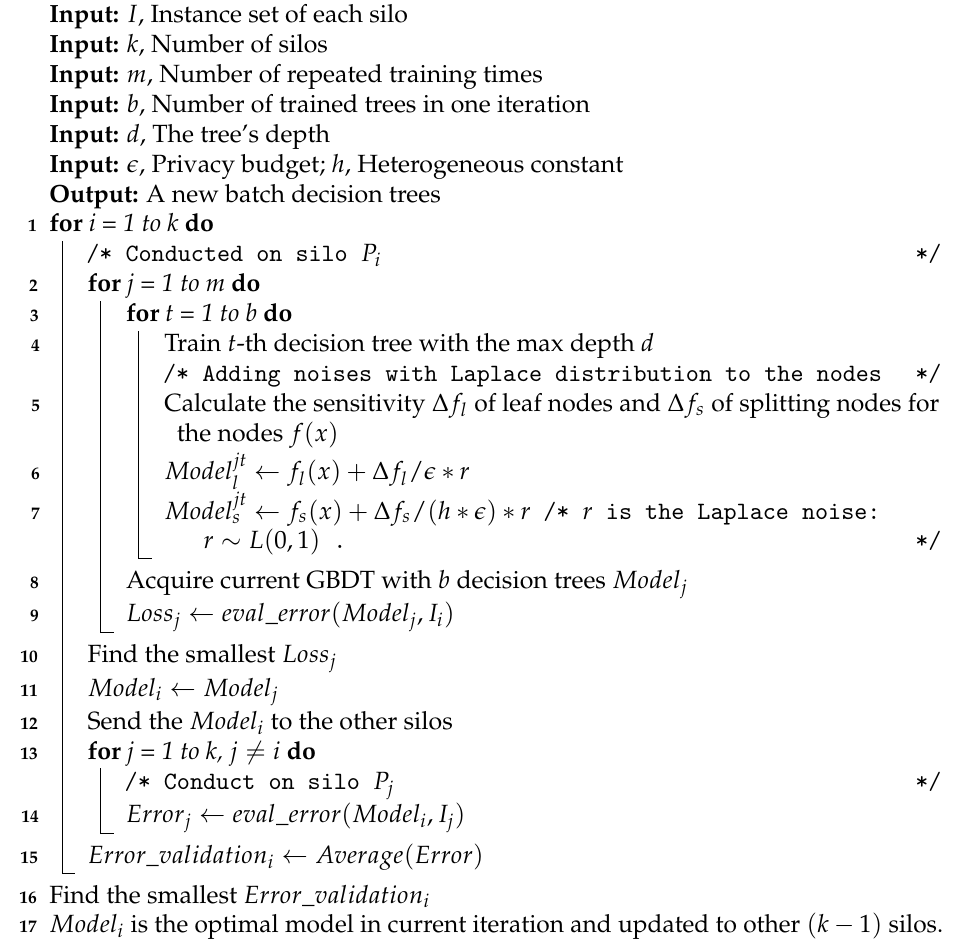
Algorithm 1: The FedVoting process among silos in one